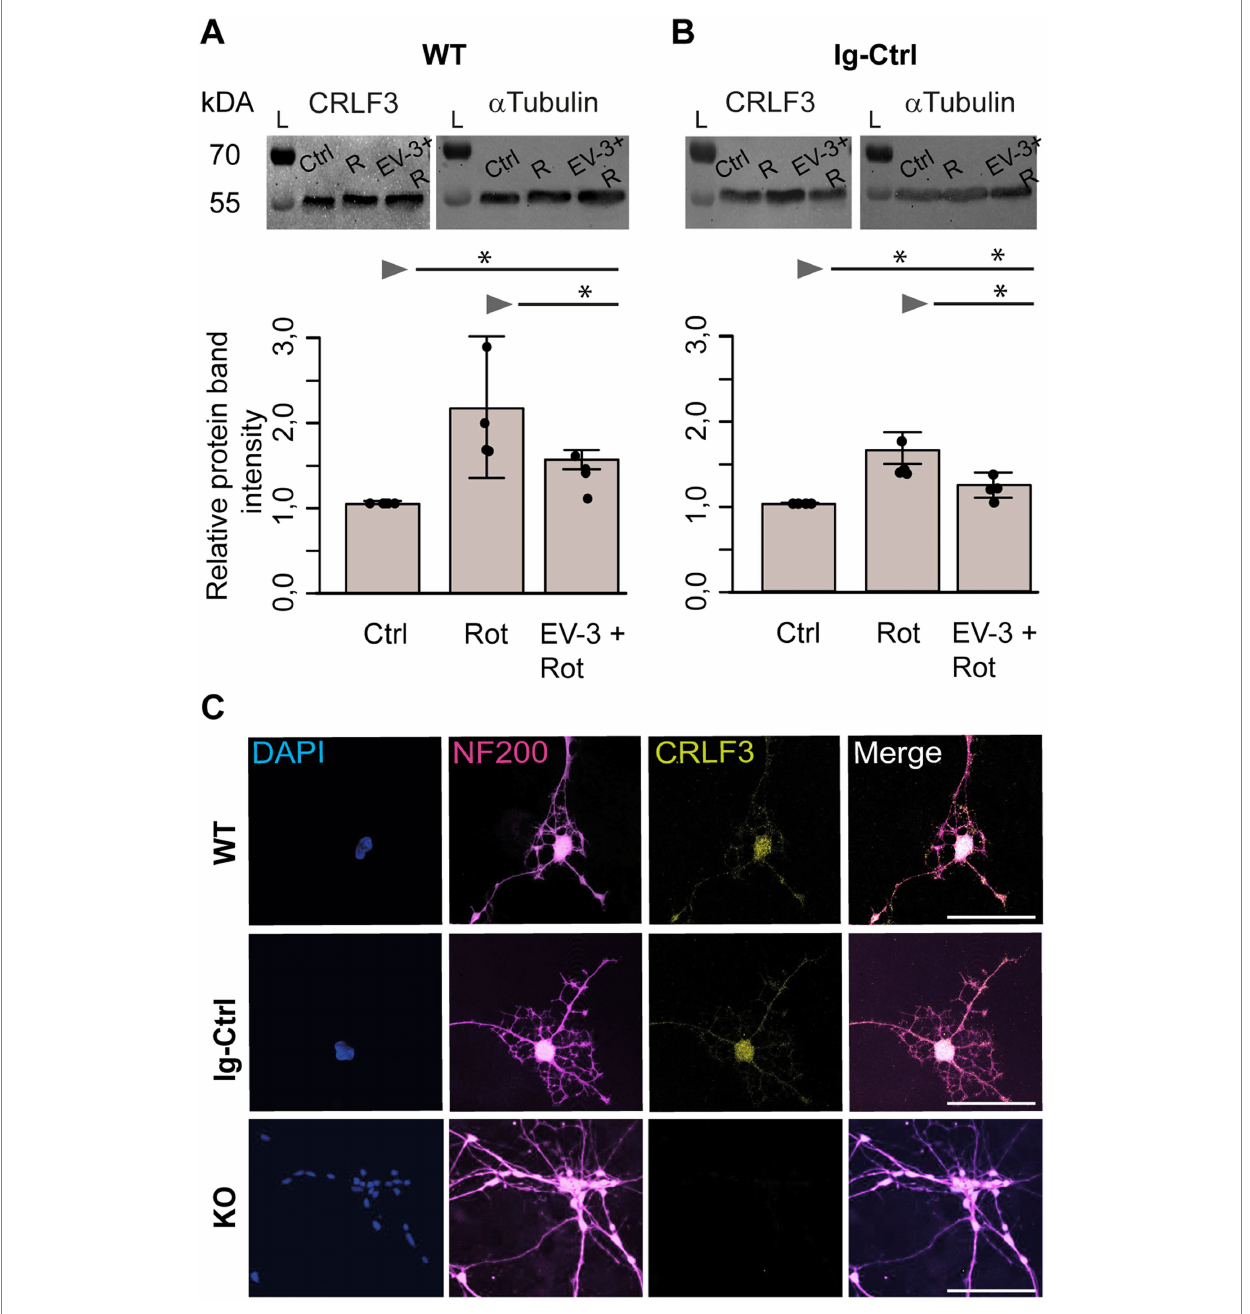
FIGURE 6 CRLF3 protein levels in apoptogenic and rescue conditions. Treatment with EV-3 and/or rotenone for 12 + 18 h started on day 30 of the differentiation protocol. Immediately after treatment, samples were collected. (A,B) Protein immunoblots of iPSC#1-derived WT (A) and Ig-Ctrl (B) neurons labeled with anti-CRLF3 (left) and anti- α -Tubulin (right) as loading control. Both antibodies labeled single bands of the expected molecular size (both ~55 kDa) in each sample. Rotenone (800 nM) increased CRLF3 protein levels in WT and Ig-Ctrl neurons. Co-treatment with EV-3 (41.5 ng/mL) reduced rotenone- induced CRLF3 accumulation insignificantly in WT and significantly in Ig-Ctrl neurons. n = 4. Data is shown as bar plots representing the average band intensities together with the calculated standard deviation and single data points. Statistics: pairwise permutation test with Benjamini-Hochberg correction for multiple comparison. Significant differences: * p < 0.05. (C) Immunofluorescent labeling of neurofilament 200 (NF200; neuronal/axonal marker) and CRLF3 in all iPSC#2-derived neurons. Nuclei were labeled with Dapi. CRLF3 immunoreactivity in WT and Ig-Ctrl covers entire neurons with extensive labeling in the soma. No CRLF3 immunoreactivity is detected in KO cells. Scale bars 100 μ